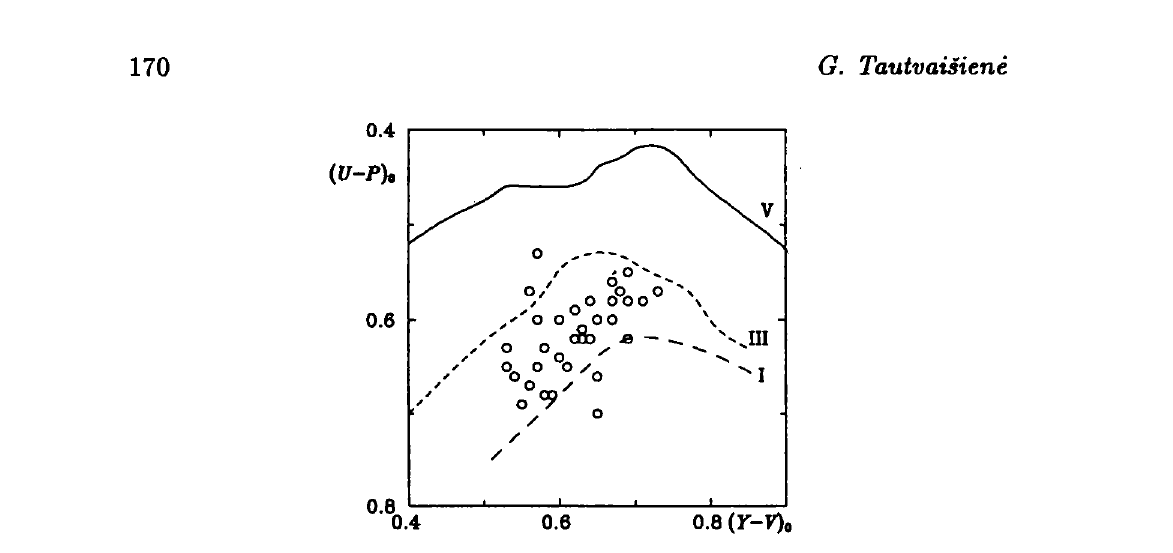
Fig. 1. Location of suspected red horizontal branch stars in the (U-P)o, (F-V)o diagram of the Vilnius photometric system. Sequences of normal supergiants, giants and dwarfs are shown.